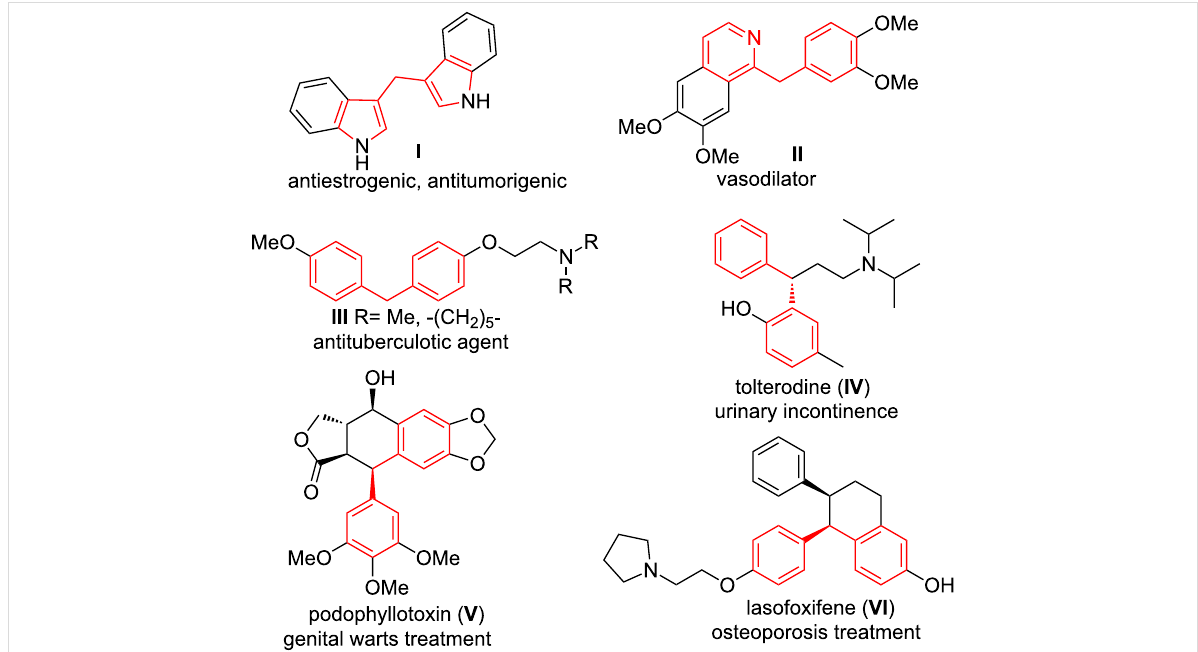
Figure 1: Structures of biologically active diarylmethanes and commercially available pharmaceuticals based on the diarylmethyl moiety.